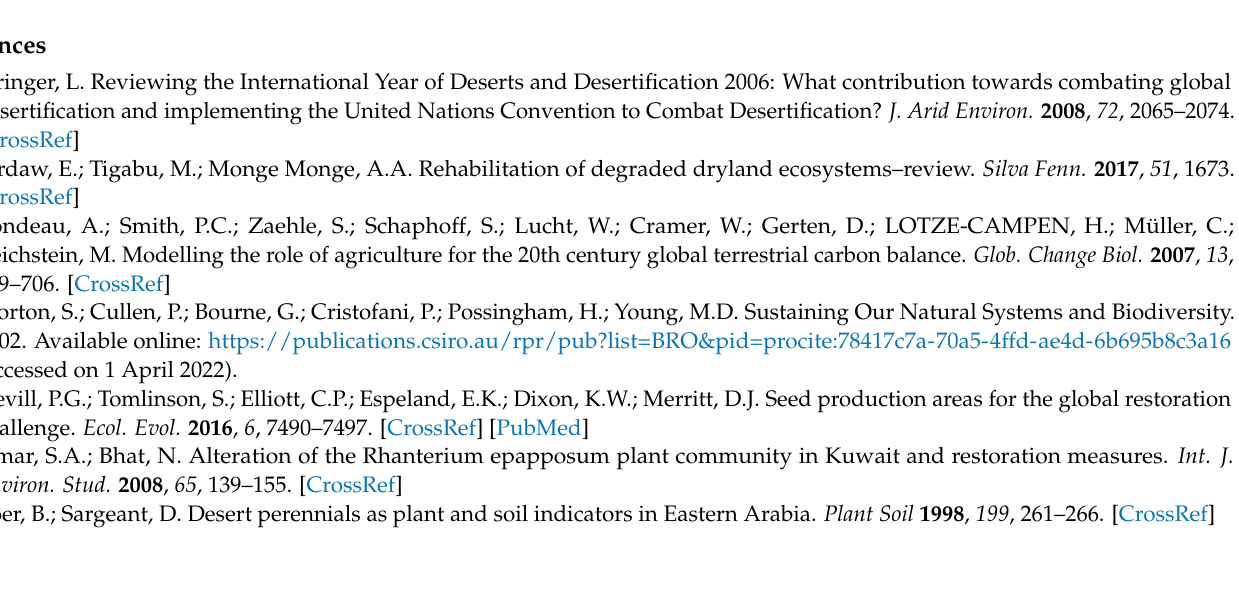
Table S2: Position of SNPs and Indels on each scaffold and Table S3: GPS coordinates and soil types of Rhanterium populations growing in